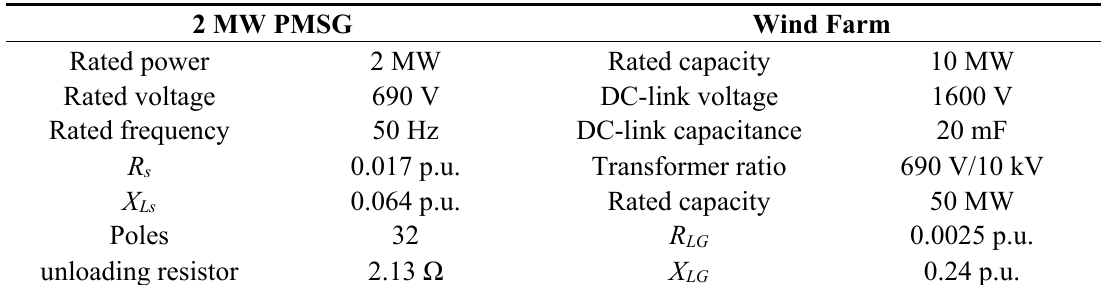
Table A1. Parameters of PMSG and wind farm